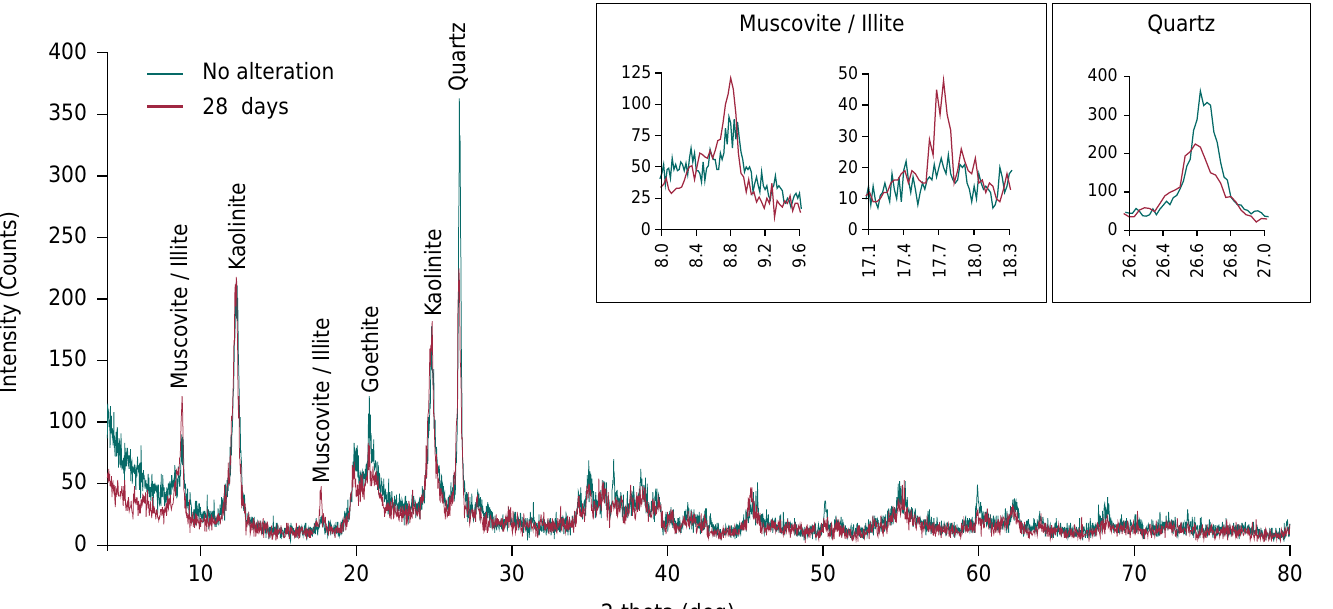
Figure 1. X-ray diffractograms of the unaltered sample and sample altered over 28 days with alkaline solution. The highlighted peaks evidence changes in quartz and muscovite/illite